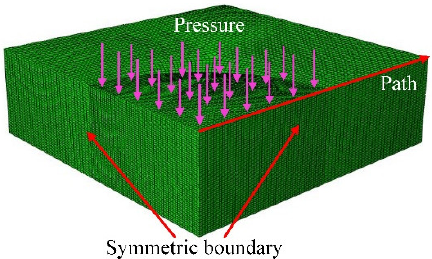
Figure 1. Three-dimensional axial-symmetry finite element model.